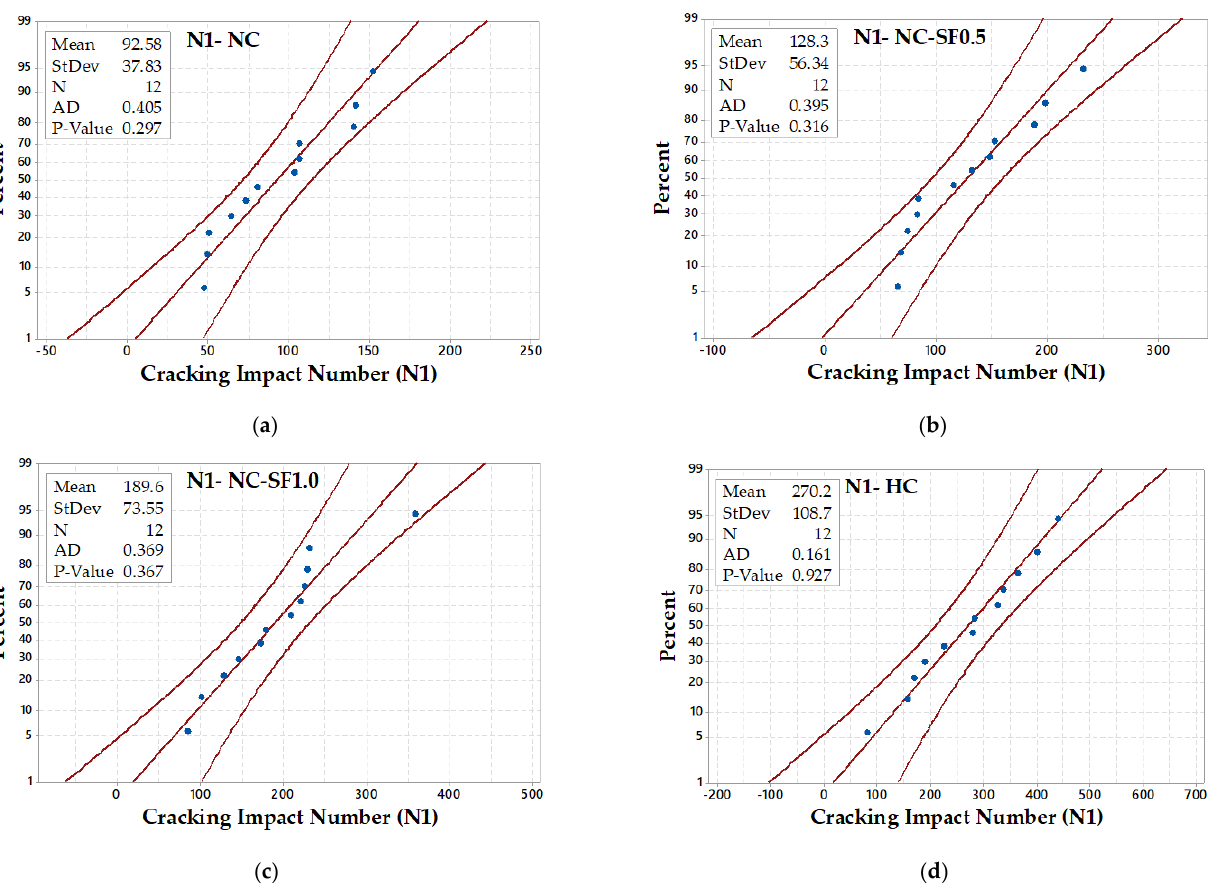
Figure 10. Normal probability plots of the results at the cracking stage for mixtures ( a ) NC ( b ) NC-SF0.5 ( c ) NC-SF1.0 and ( d ) HC.